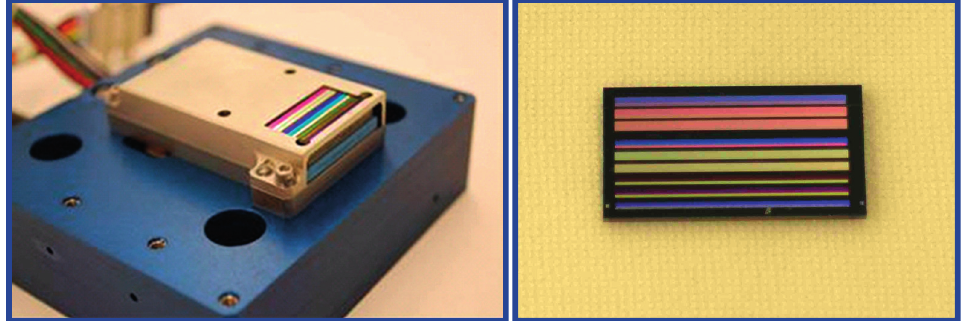
Figure 8. An individual focal plane module ( left ); an individual spectral filter assembly ( right